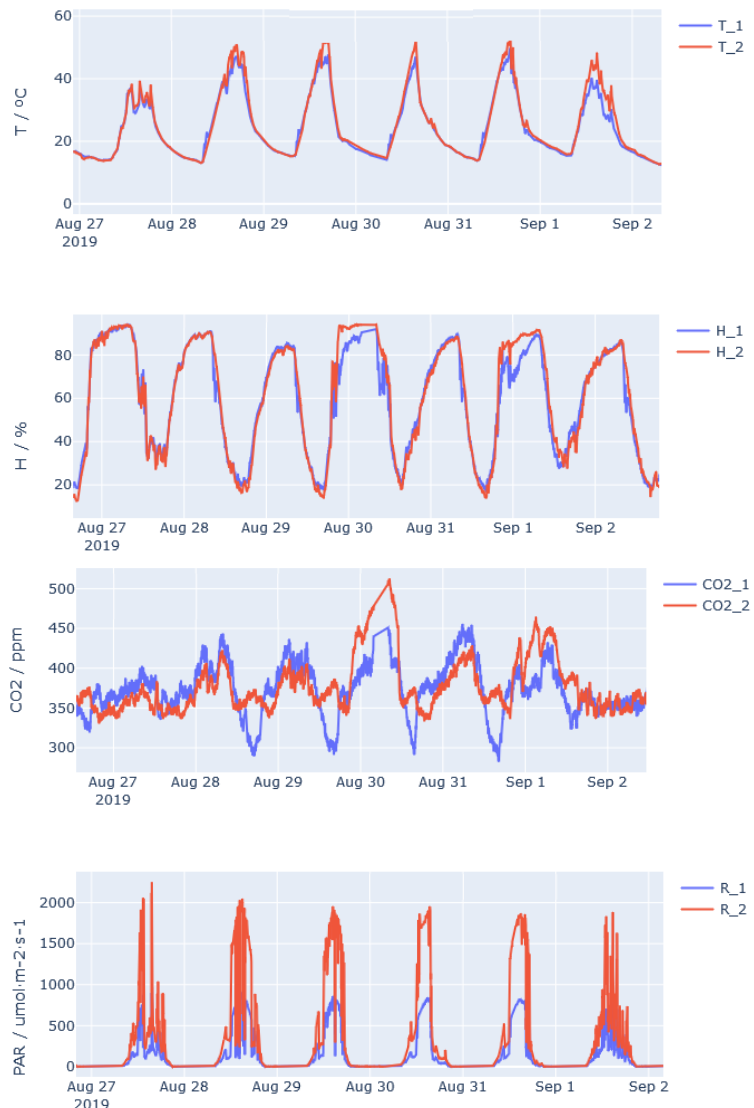
Figure 11. Evolution before planting of temperature, relative humidity, concentration of CO 2 and PAR radiation (1: PV glasses, 2: conventional glasses).